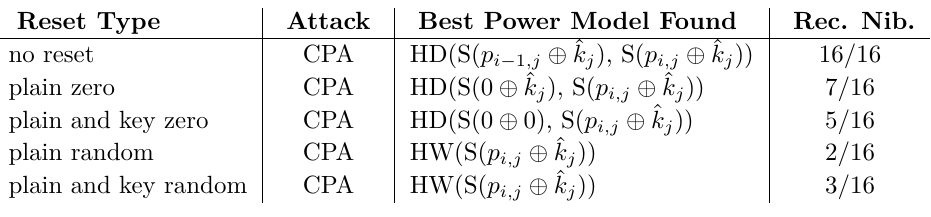
Table 7: Summary of the optimal attack results (among all tested ones) for the 5 dynamic power scenarios respectively with a maximum of 500 000